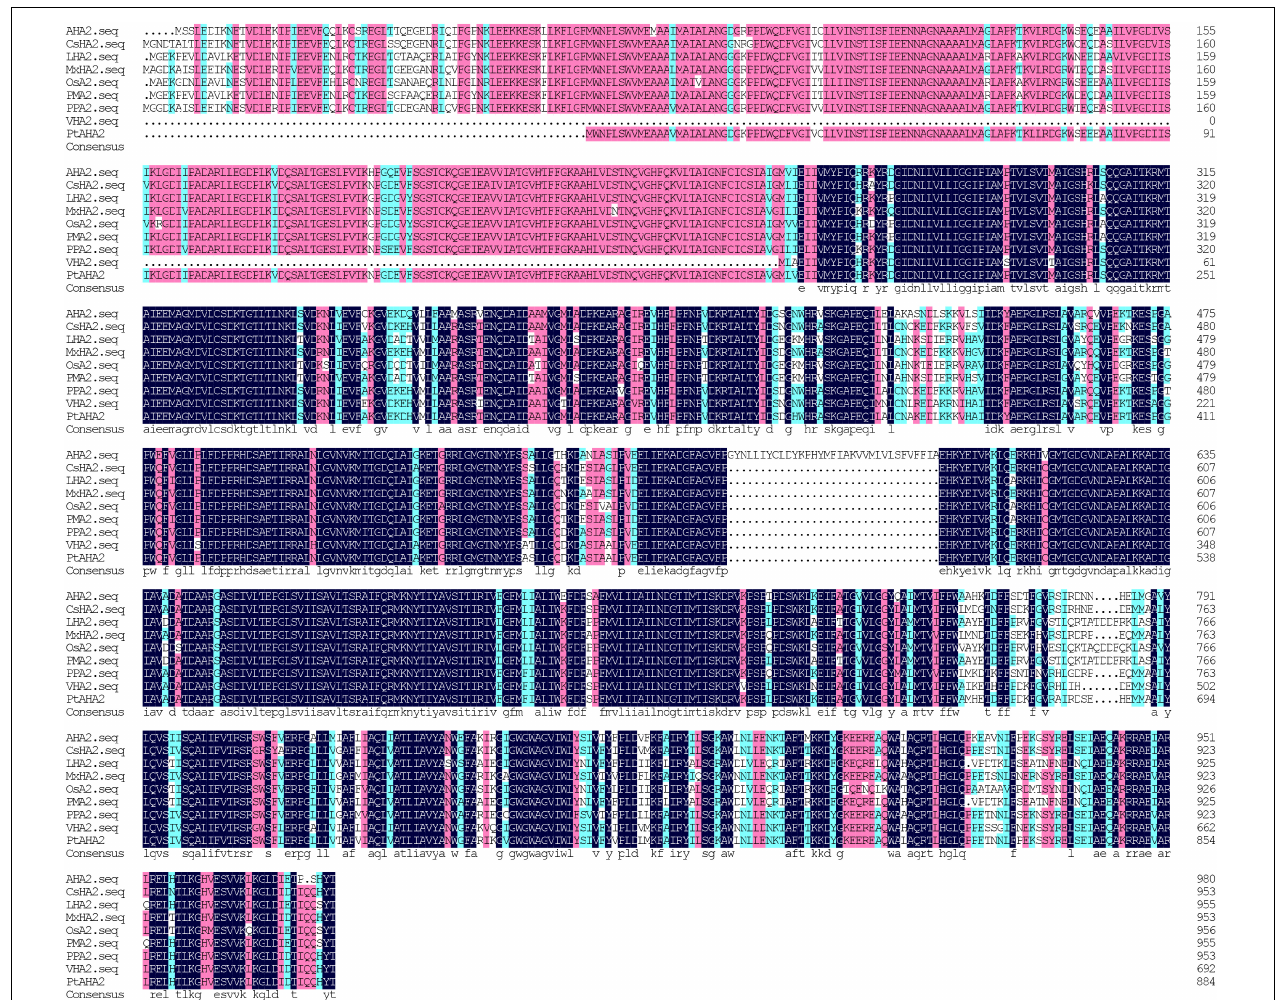
FIGURE 3 | Sequence alignments of PtAHA2 with HA2 proteins from other plants. AHA2 : Arabidopsis thaliana ; CsHA2 : Cucumis sativus ; LHA2 : Lycopersicon esculentum ; MxHA2 : Malus xiaojinensis ; OSA2 : Oryza sativa ; PPA2 : Prunus persica ; VHA2 : Vicia faba ; PtAHA2 : Poncirus trifoliata .